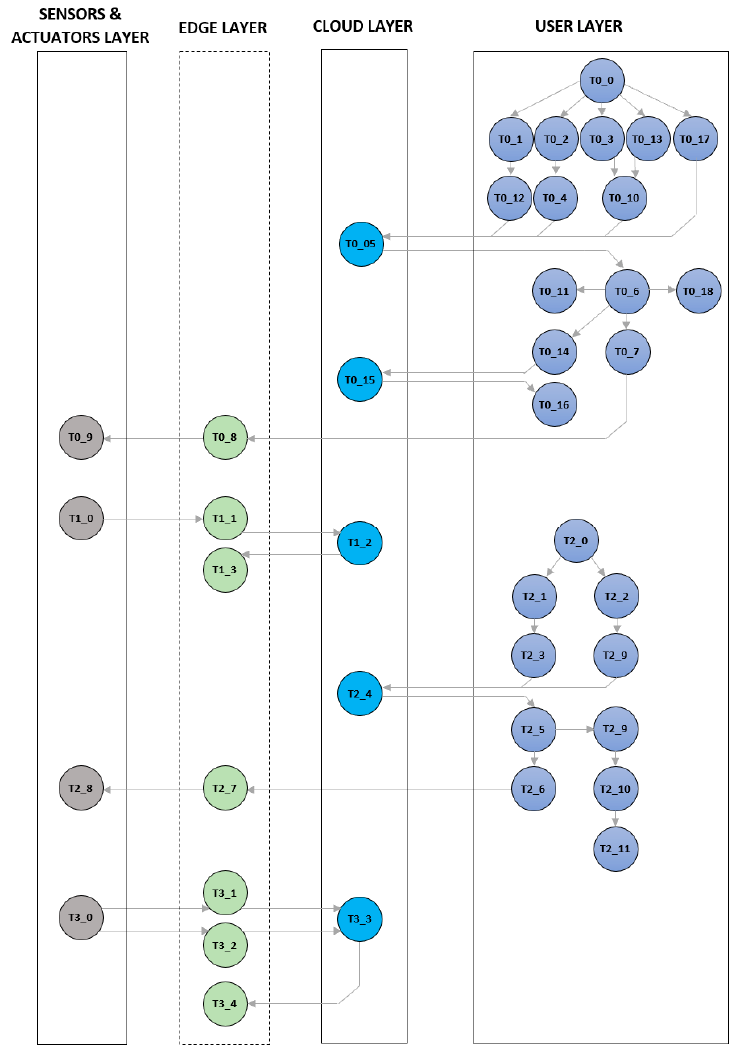
Figure 7. Mapping the described processes to RTIoT system architecture.